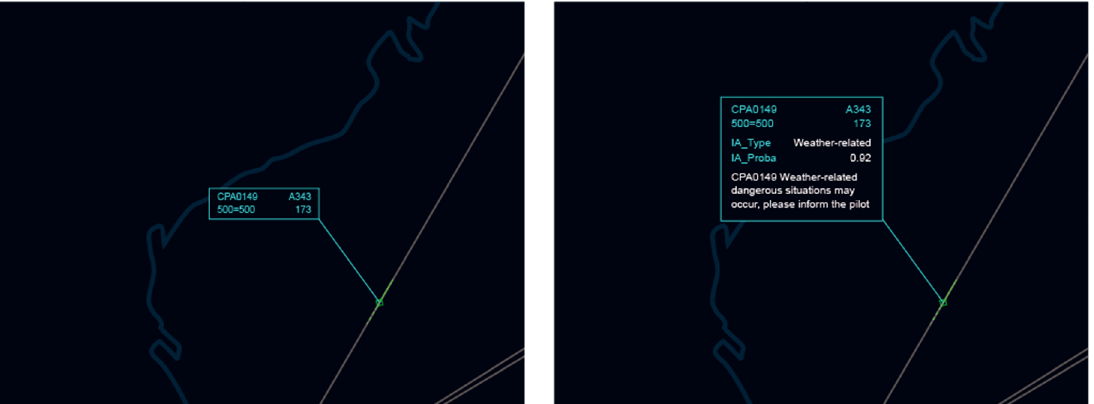
Figure 20. Detailed visual interaction in prompt mode.